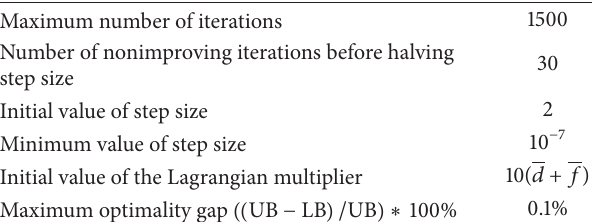
Table 1: Parameter of the Lagrangian